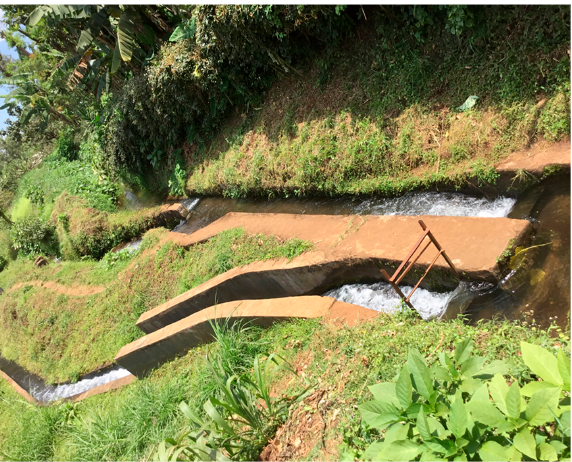
Figure 2. Irrigation furrows along Isie River, Kibosho (image courtesy of the GIS Laboratory, Stella Maris Mutwara University College). In Marangu and Kilema we observed and recorded several furrows running alongside different rivers. Surveys in Machame revealed the difficulty inherent in mapping and constructing water channels for irrigation on the part of Chagga ancestors. Chagga civil engineers utilised intense knowledge of the landscape, which they navigated from the intake point on the river to the required water supply points. Water flow velocity is another important consideration in the construction of furrows. However, the proximity of villages (the user end-points user) to the source or intake point (the river) was not as essential as the terrain contour and the maintenance of the infrastructure. For example, Mamba is one of the longest furrows in Machame (Figures 2 and 3), stemming from the Kikafu River and with its initial intake lying in the Kilimanjaro Forest Reserve.